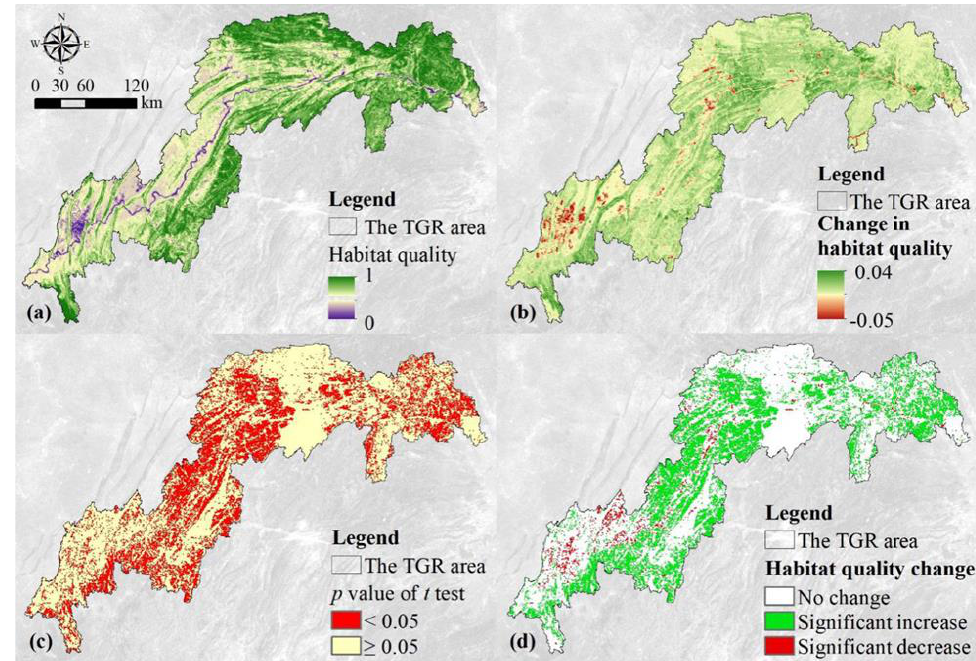
Figure 3. Spatio-temporal variation of the habitat quality in the TGR area between 2000 and 2015. Average ( a ) and the modelled slope ( b ) of the habitat quality, and p value of t test for the modelled slope ( c ) and the habitat quality changes ( d ). Note: In the figure ( d ), no change documents that the habitat quality did significantly no change (slope = 0), and significant increase refers to slope > 0 and p < 0.05, while significant decrease refers to slope < 0 and p < 0.05.